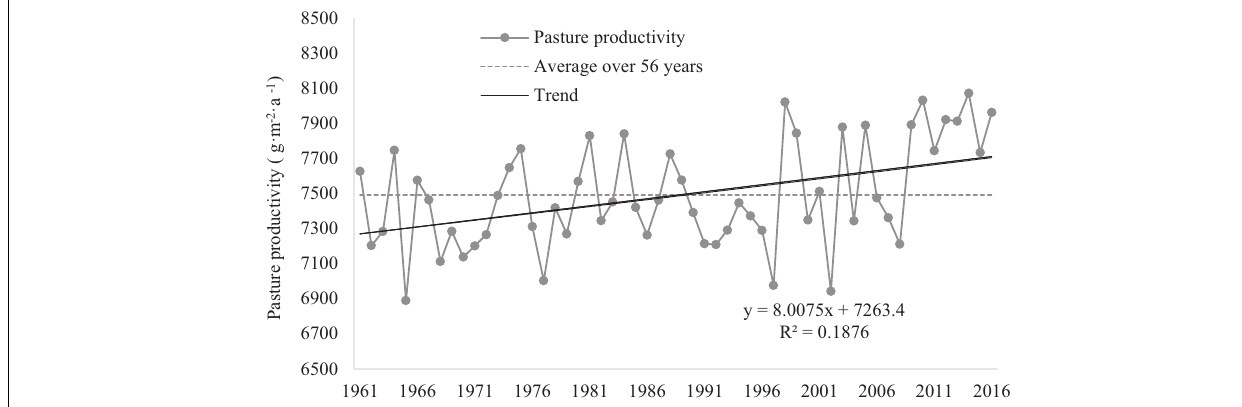
FIGURE 6 | Interannual variation in pasture productivity from 1961 to 2016.